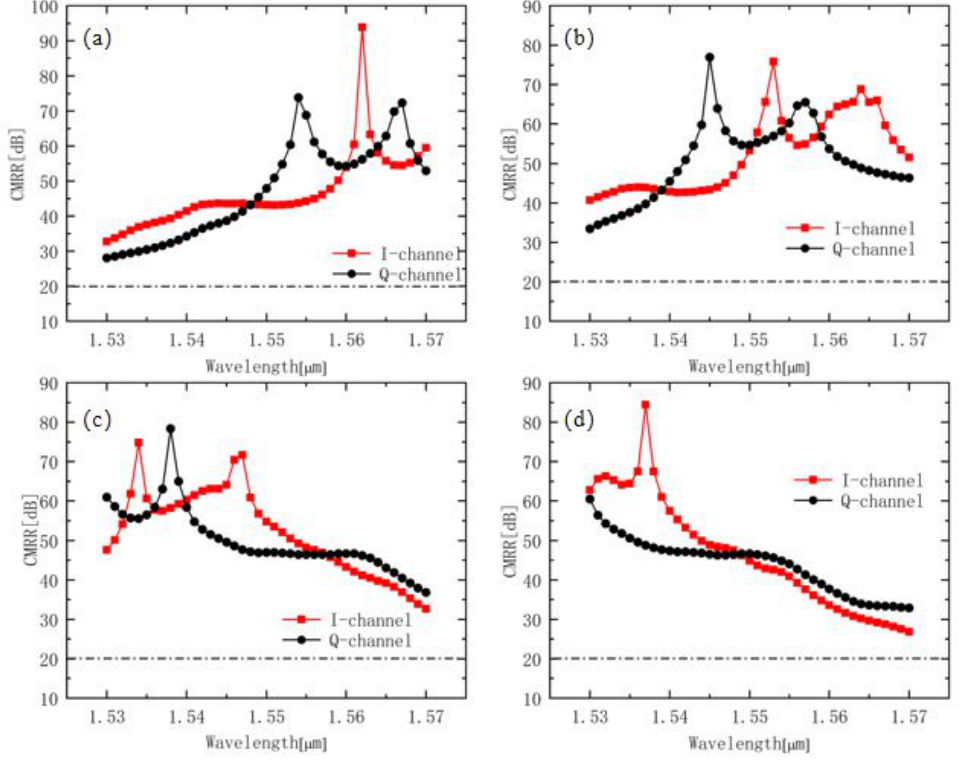
Figure 7. Simulated CMRR of the hybrid with different interference lengths of ( a ) 832 μm, ( b ) 837 μm, ( c ) 847 μm, and ( d ) 852 μm across the C-band.